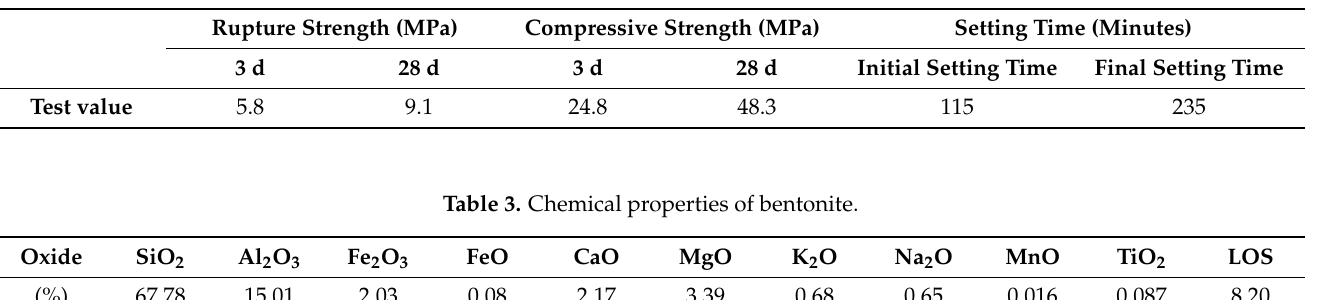
Table 2. Properties of cement.